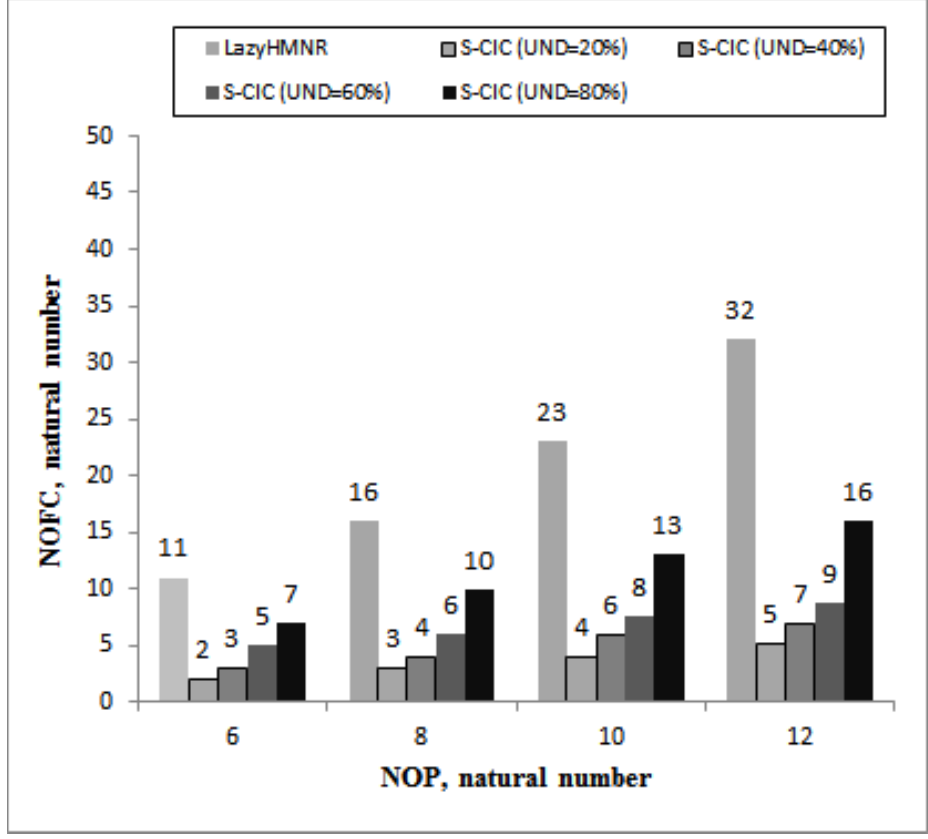
Figure 5. NOFC for the serial